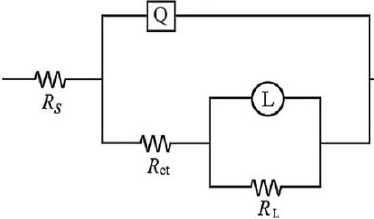
Figure 6. Simulated equivalent